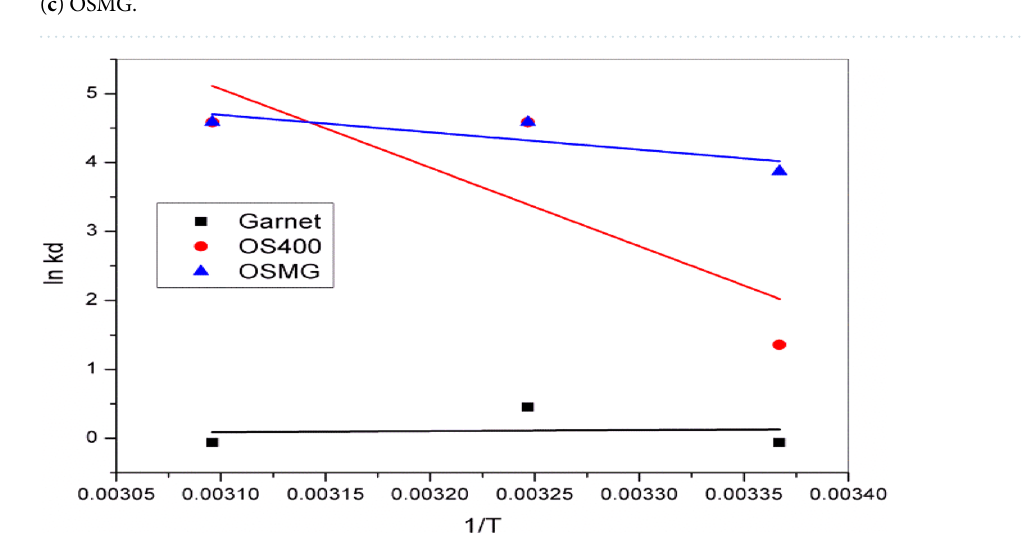
Figure 14. Van’t Hoff thermodynamics model for GA, OS400 and